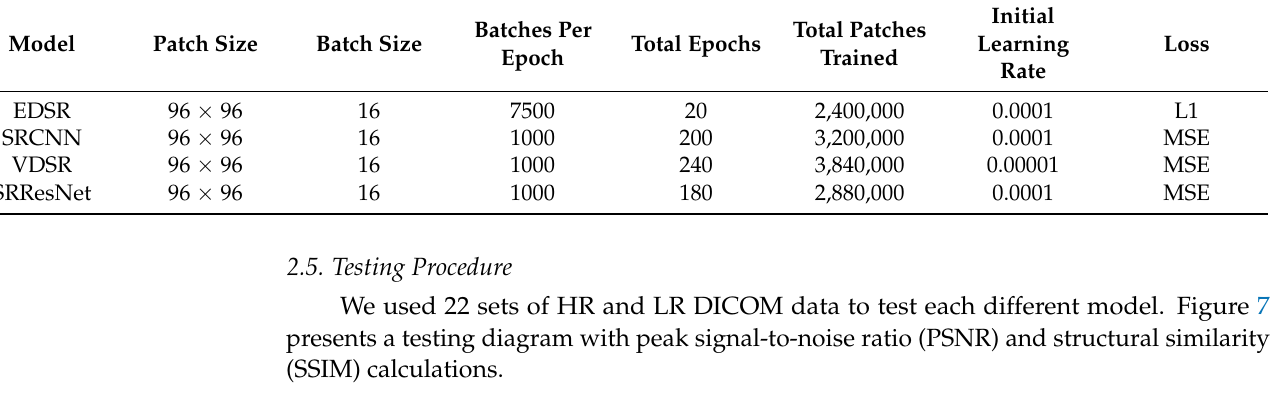
Table 2. Training settings for each model.